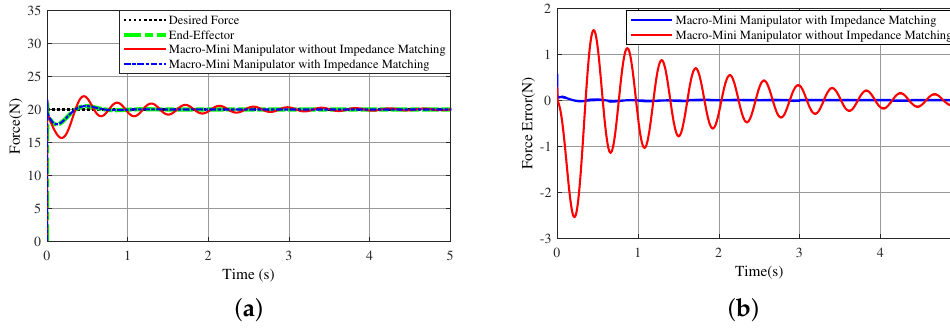
Figure 6. Simulation results of direct force control: ( a ) Results of step force control for end-effector, macro-mini manipulator with or without impedance matching. ( b ) Compared with the force control results of the end-effector alone, the force errors of the macro-mini manipulator with or without impedance